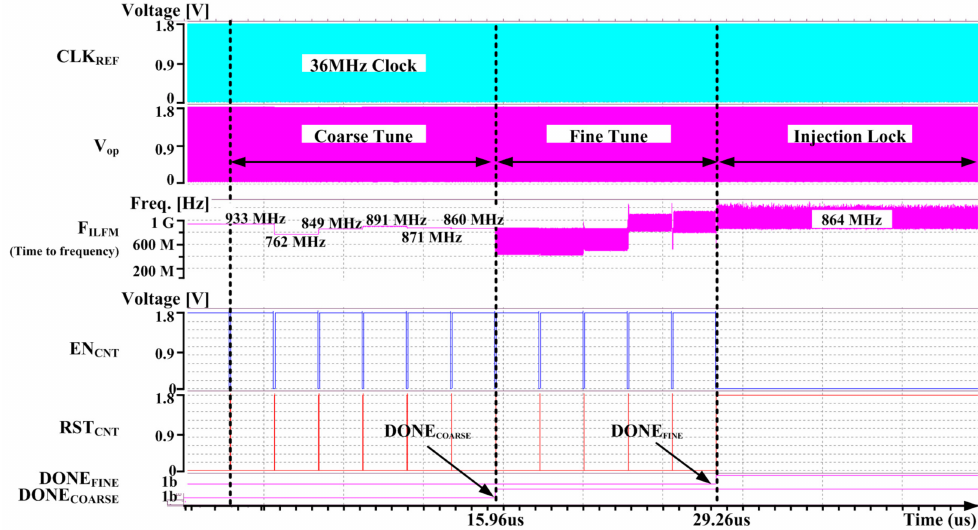
Figure 10. The top simulation of